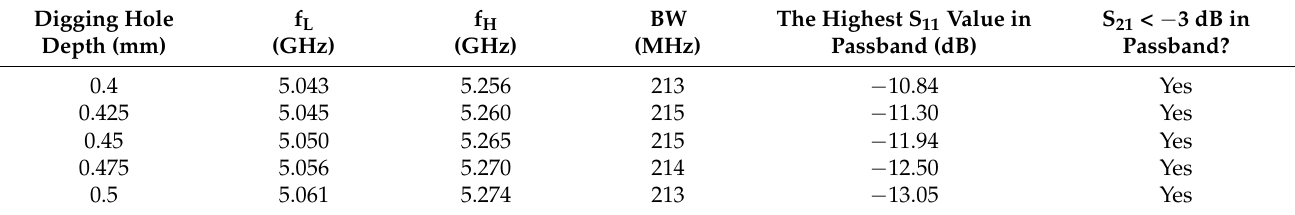
Table A3. The simulation results obtained with a fixed digging depth of 0.1 mm and various digging radii. Digging Hole Depth